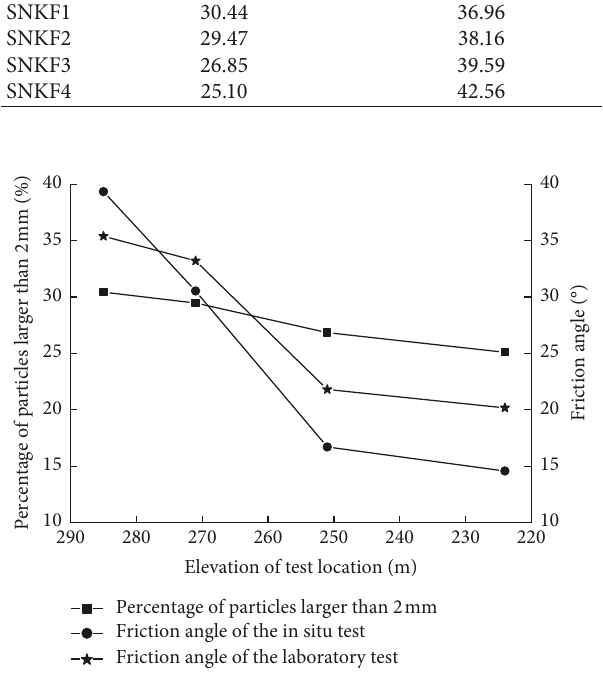
Figure 13: Percentage of particles larger than 2mm and the friction angle versus the elevation of test location.